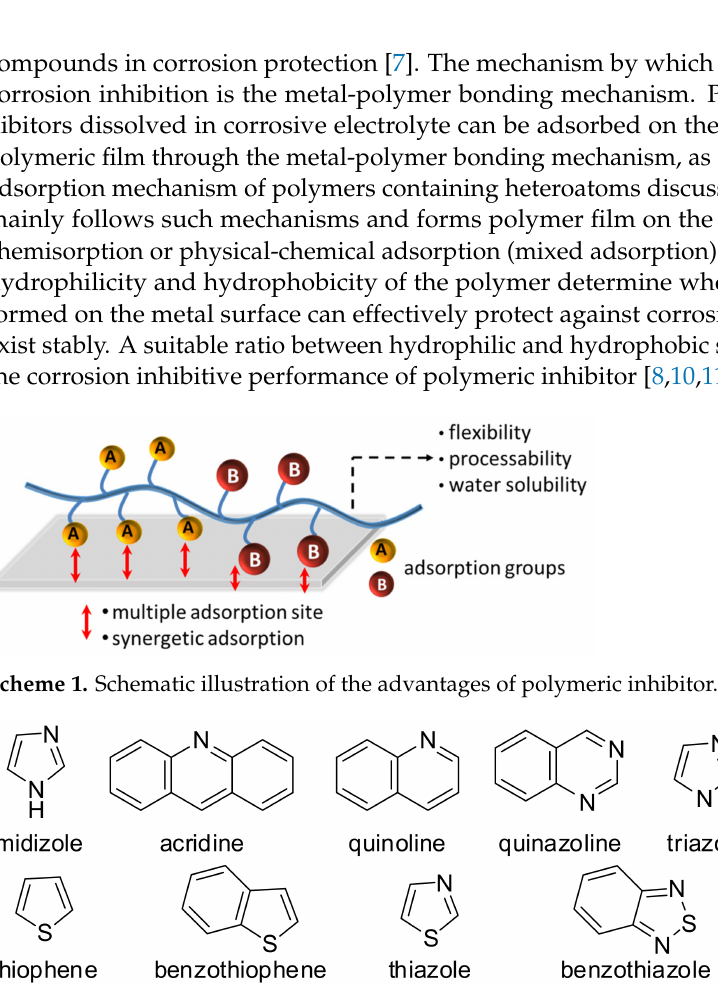
Figure 1. Chemical structures of typical heterocyclic compounds used in the design of inhibitors.